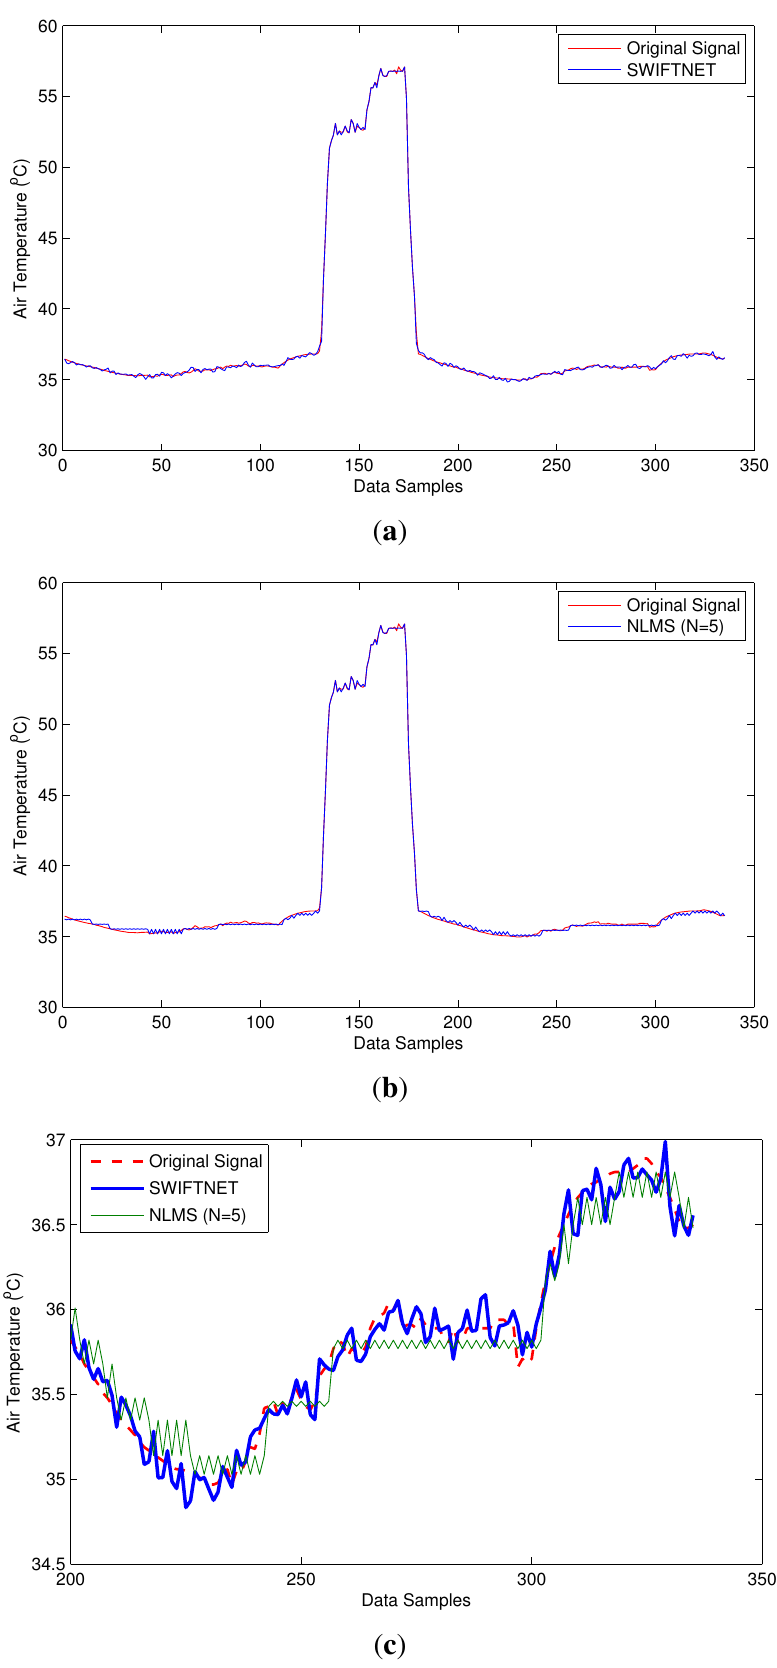
Figure 8. Signal reconstruction from Node 1, for a 1-day wildfire monitoring test-burn using a 40 ◦ C threshold cut-off point. The sparsity rate K is set to 25% at 5 min sampling interval: ( a ) Example SWIFTNET data trace; ( b ) Example data trace from default adaptive prediction method; ( c ) A snapshot of real and predicted sensor